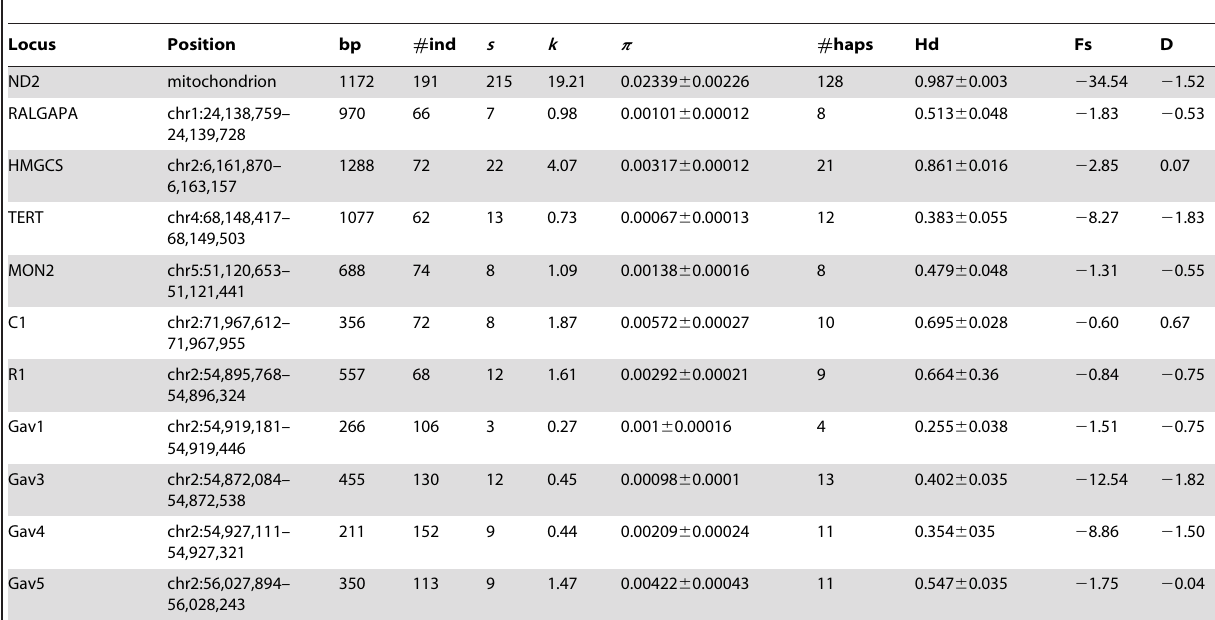
Table 1. Overiew of genetic data.